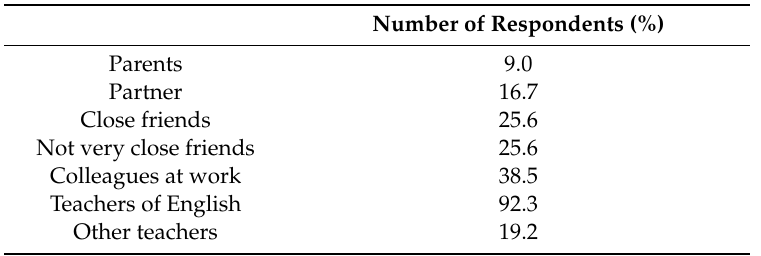
Table 3. The use of English names with certain groups of